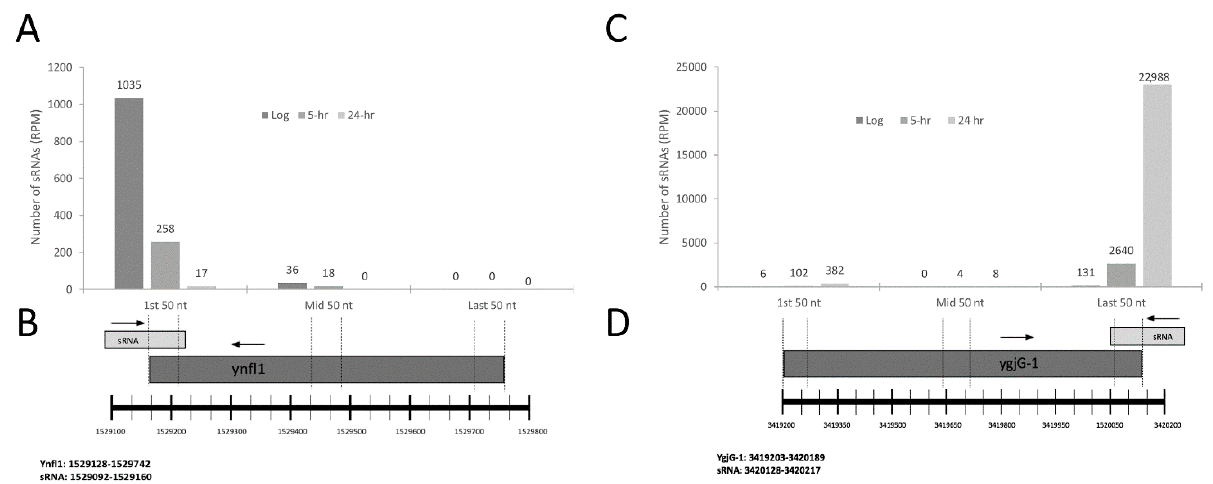
Figure 3. Overlapping sRNAs and protein coding genes have distinct expressions. ( A ) Gene expressions measured at distinct locations within the shared sRNA1529092/ynfl1 locus. ( B ) Illustration depicting locations aligned to RNA seq data to determine expressions shown in ( A ). ( C ) Gene expressions measured at distinct locations within the shared sRNA3420128/ygjG-1 locus. ( D ) Illustration depicting locations aligned to RNA seq data to determine expressions shown in ( C ). Chromosomal start and stop positions for each protein coding gene and sRNA are listed. Transcriptional direction is indicated by an arrow just above a sRNA / gene name.